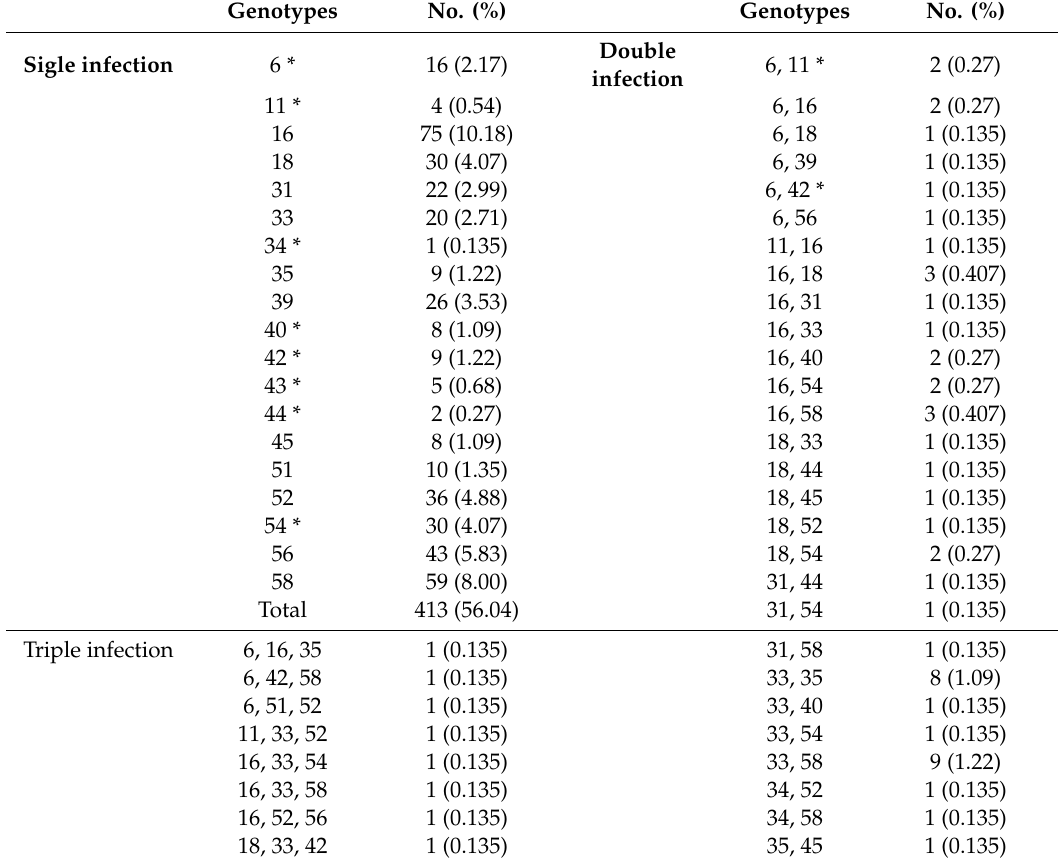
Table 2. HPV Genotypes in the MyHPV CHIP ™